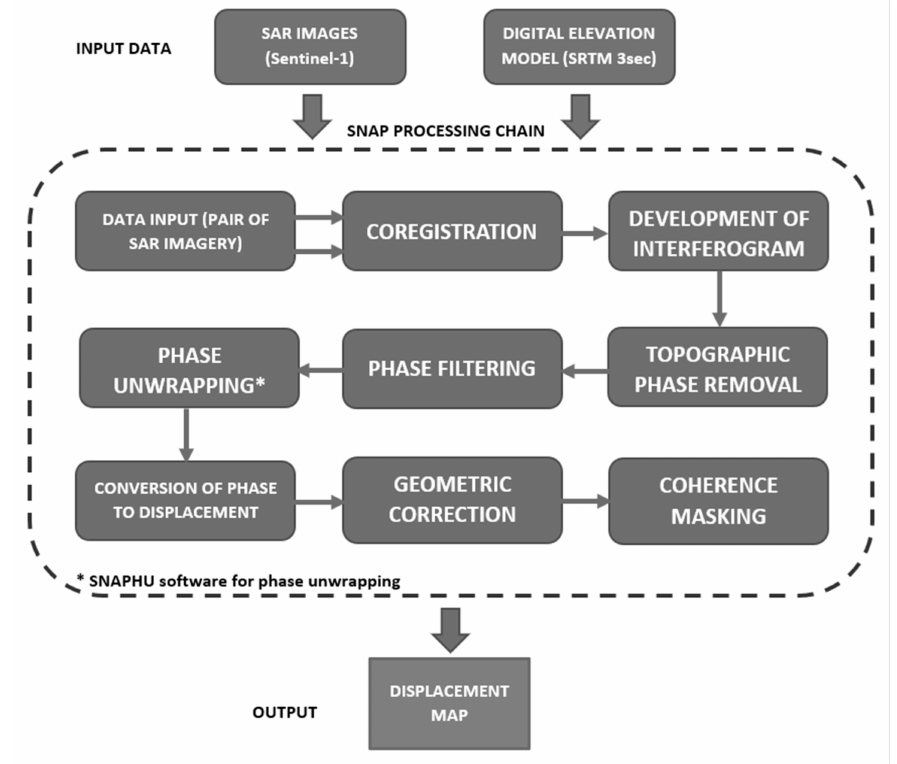
Figure 2. Outline of the Displacement Map Processing